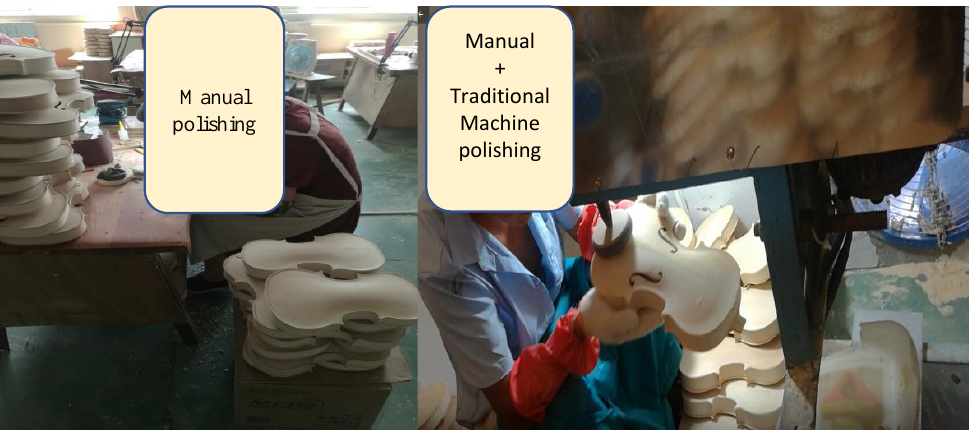
Figure 6. Manual polishing of violin